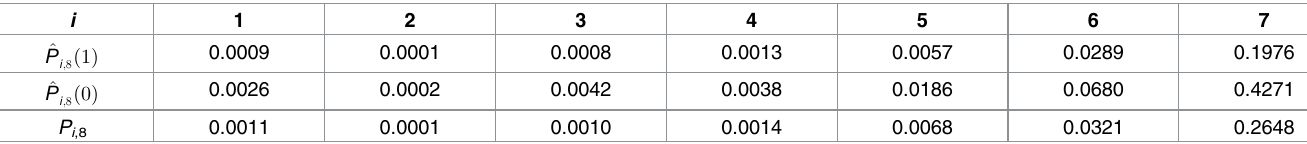
Table 6. M = 7, model 1: Conditional vs. historical default probabilities.